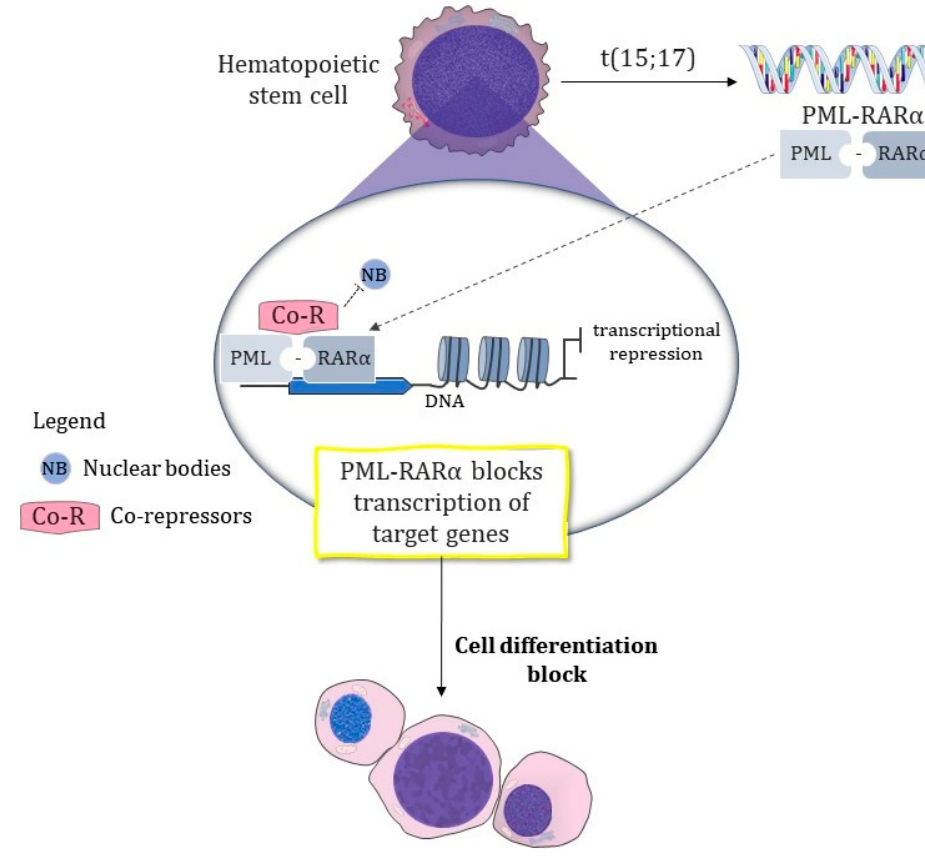
Figure 2. RAR transcriptional pathway regulating hematopoietic development through PML-NB disruption. The presence of the PML-RAR α fusion protein causes the repression of a transcriptional complex of RAR genes, compromising hematopoietic cell maturation.